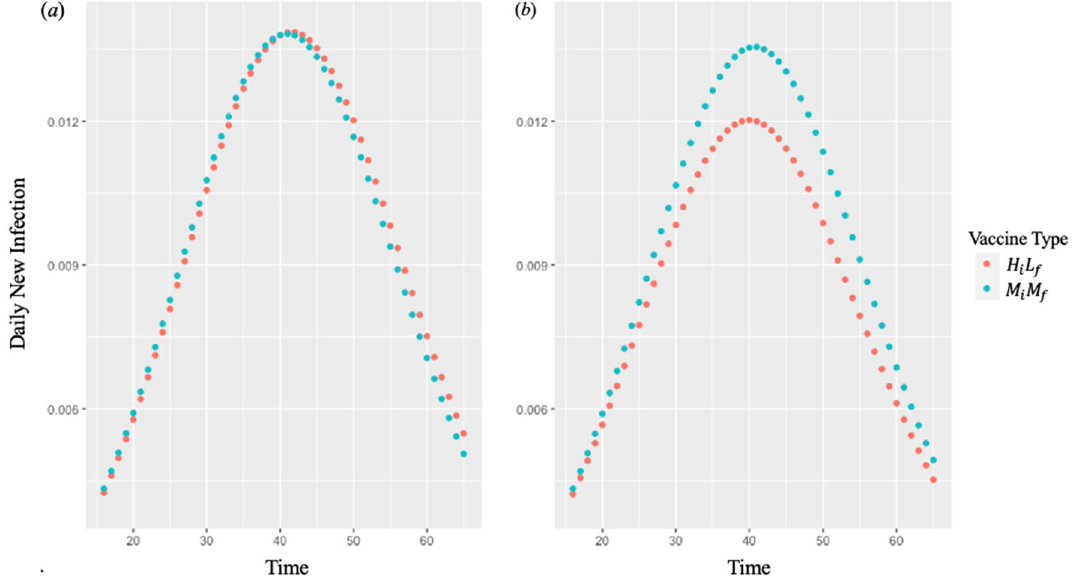
Figure 3. Daily new infections from day 15 to day 65 with vaccine- H i L f and vaccine- M i M f when the capacity multiplier ( (cid:31) ) is 3 and the mutation time is ( a ) day 10 and ( b ) day